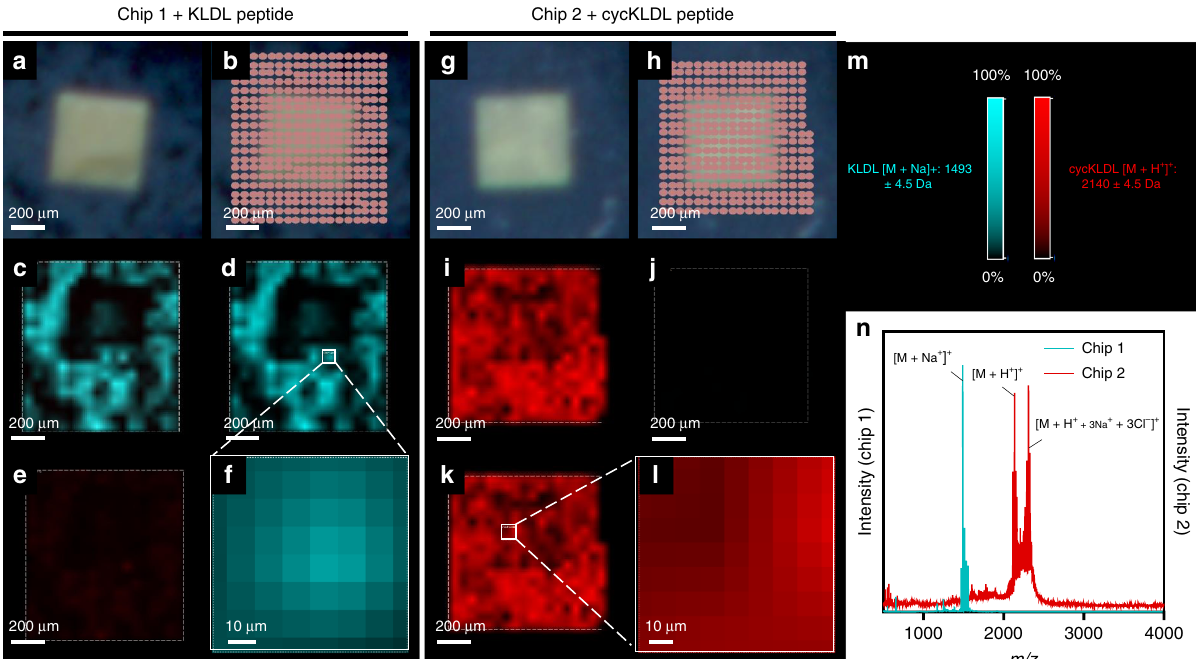
Fig. 4 MALDI-IMS of LCTEM chips after assembly as a liquid cell containing KLDL or cycKLDL peptide. a – f Analysis of LCTEM chip with 10-nm-thick silicon nitride (SiN x ) membrane window, coated with KLDL peptide. a Optical image of a square window of SiN x LCTEM chip. b Map of laser spots with raster size of 50 µ m. c Intensity map of merged KLDL and cycKLDL signal. d Intensity map of KLDL signal only. ROI for magni fi cation in white box. e Intensity map of cycKLDL signal only. f Magni fi ed ROI showing 2D map pixels. g – l Analysis of chip coated with cycKLDL peptide. g Optical image of square window of SiN x LCTEM chip. h Map of laser spots with raster size of 50 µ m. i Intensity map of merged KLDL and cycKLDL signal. j Intensity map of KLDL signal only. k Intensity map of cycKLDL signal only. ROI for magni fi cation in white box. l Magni fi ed ROI showing 2D map pixels. m Color intensity is displayed as 0 – 100% of total intensity on a logarithmic scale for each fi lter within the analyzed region. n Total averaged MALDI mass spectra from each chip plotted as absolute intensity vs. m/z . Filter (with manually de fi ned range represented as ±) for KLDL [M + Na + ] + at 1493 ± 4.5 m/z is shown in red. Filter for cycKLDL [M + H + ] + at 2140± 4.5 m/z is shown in blue. Intensity is calculated as integrated intensity for mass range. Source data are provided as a Source Data fi